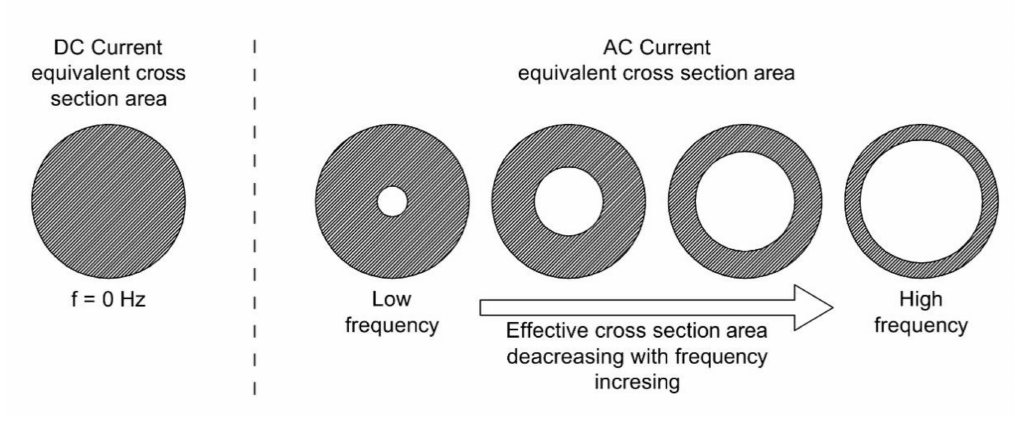
Figure 3. The skin effect dependence.